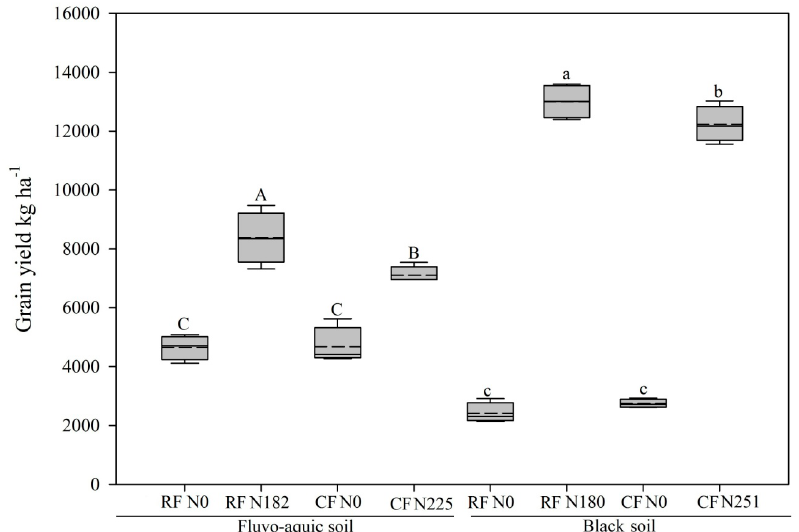
Figure 1. Maize yield in four fertilization treatments and two soil types. Box plots show median (horizontal line), mean (dotted line), 25th and 75th percentiles (box), and 5th and 95th percentiles (whisker caps). Capital letters are used to indicate significance for fluvo-aquic soil and small letters are used for black soil. Table 3. Effect of fertilization, soil type, and their interaction on soil biochemical traits, maize yield, and bacterial alpha diversity indices.